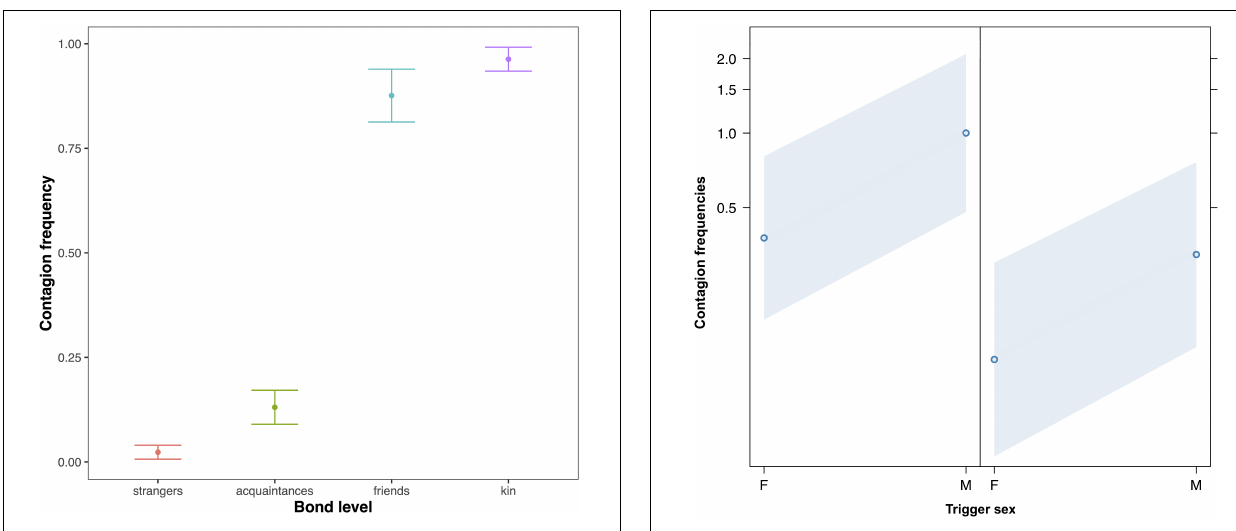
FIGURE 1 | Line plot of the effect of the social bond between trigger and responder ( X -axis) on the mean occurrence of acoustic yawn contagion ( Y -axis). Friends and kin show significantly higher yawn contagion frequencies than strangers and acquaintances (Tukey test: friends versus strangers p < 0.001; kin versus strangers p < 0.001; friends versus acquaintances p < 0.001; kin versus acquaintances p < 0.001; other combinations, ns). TABLE 1 | Results of the GLMM, including the following fixed factors: bond (0 = strangers; 1 = acquaintances; 2 = friends; 3 = kin), trigger and responder sex (M = male; F = female), trigger and responder age class (yo = youth, 15–24 years old; ad = adult, 25–64 years old; se = senior, above 65 years old), and time slot